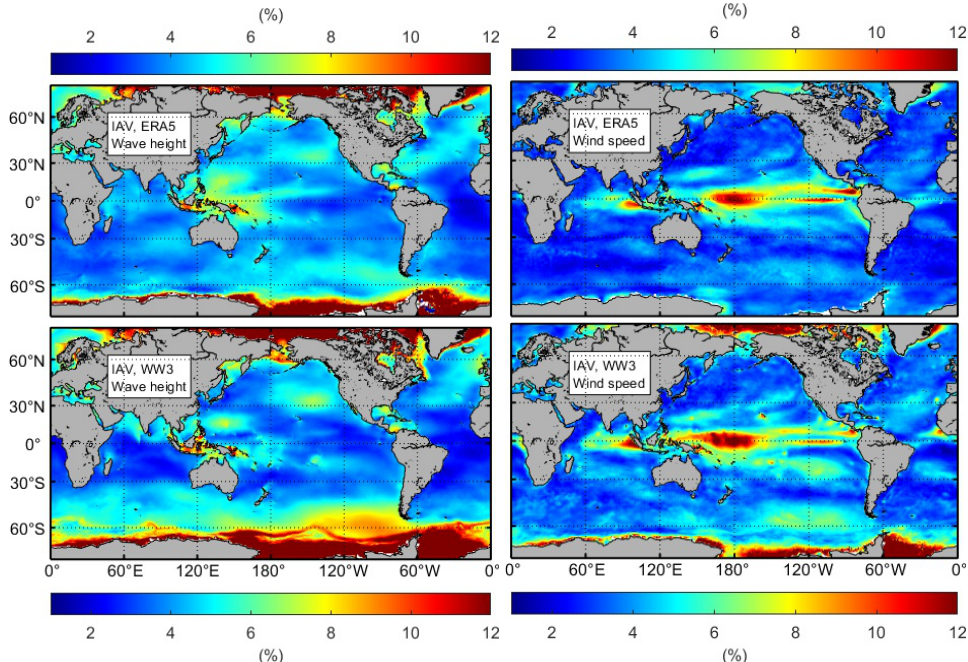
Figure 4. Inter-annual variability (in %) ( top : ERA5, bottom : WW3, left : significant wave height, right : wind